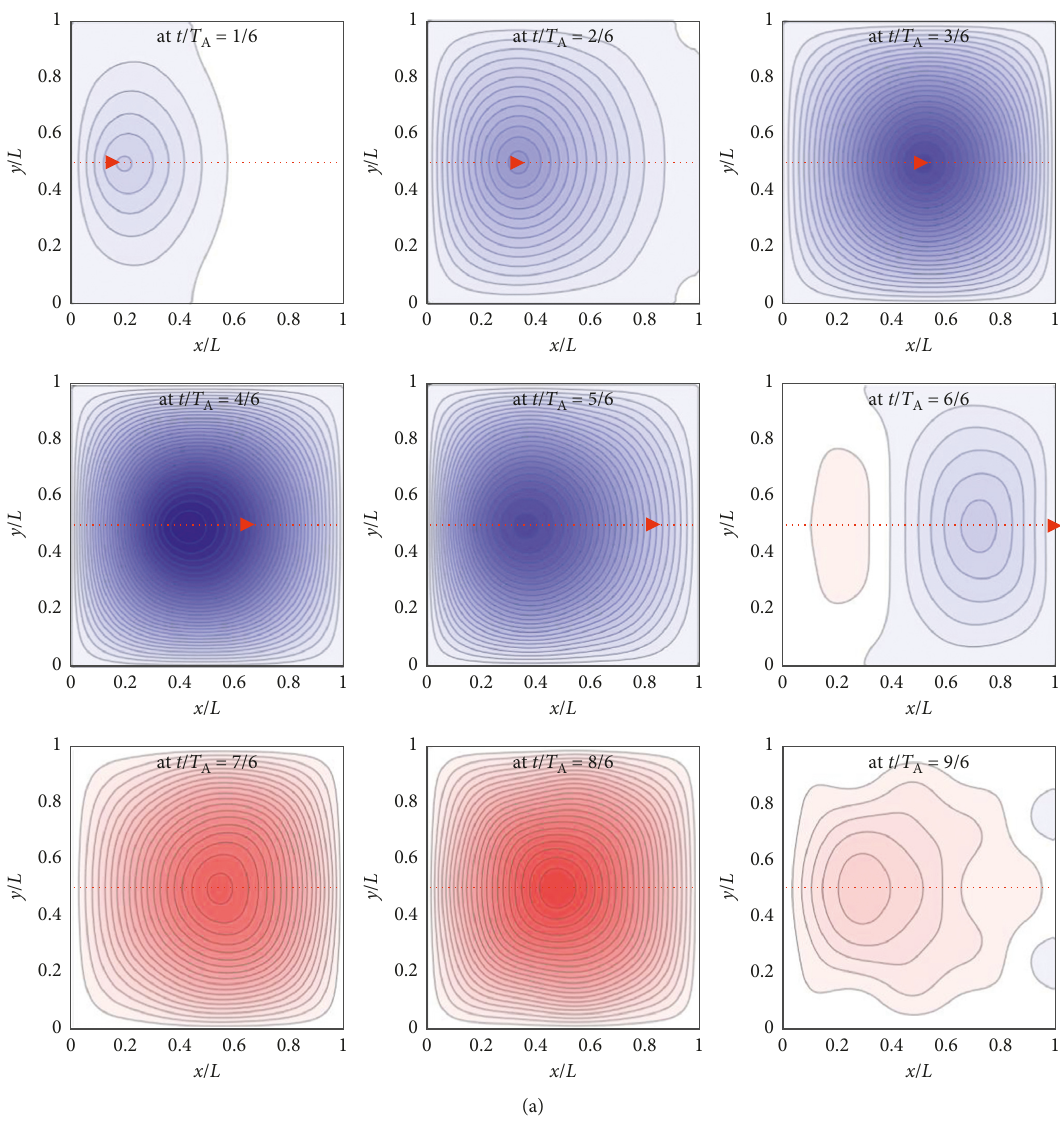
0.5 L , Y 0.5 L , (b) at X 2 L , Y 0.5 L , and (c) at X (cid:31) (cid:31) (cid:31) (cid:31)